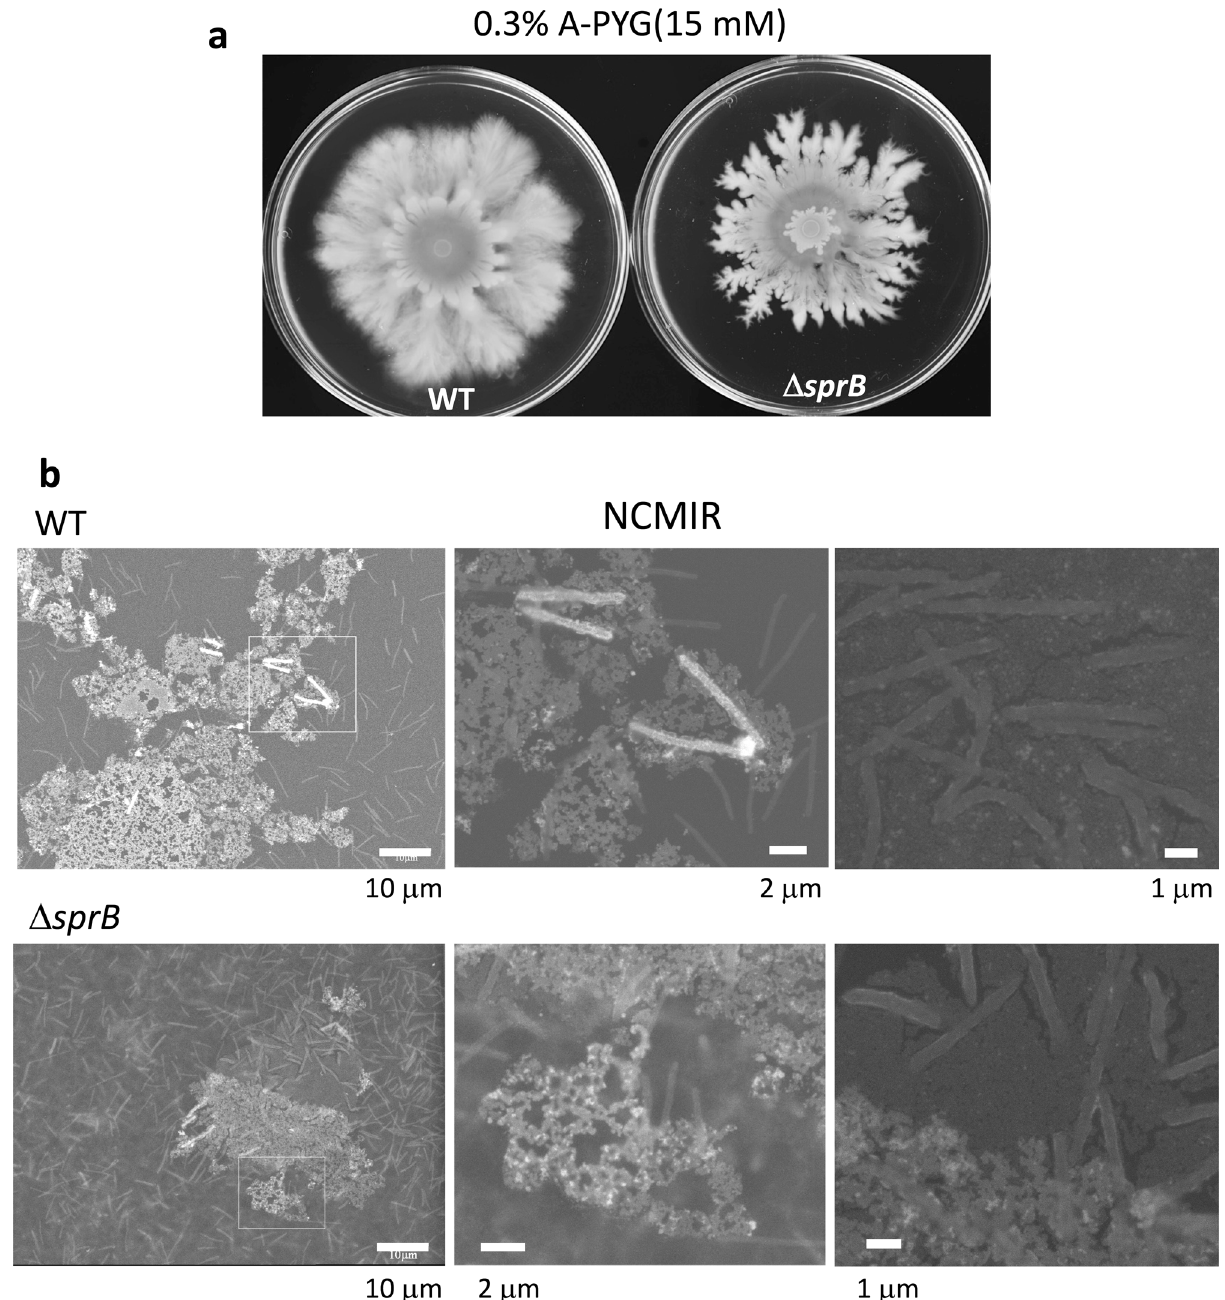
Figure 2. Colony spreading of WT and Δ sprB mutant F. johnsoniae on 0.3% A-PYG (15 mM). ( a ) Optical microscopy image. The branching pattern of the Δ sprB colony was less complex than that of the WT. ( b ) Spreading colonies of F. johnsoniae immersed in aqueous glucose buffer imaged by ASEM. The colonies were aldehyde-fixed and stained using the NCMIR method. The top of the biofilm was observed. Both WT and Δ sprB mutant cells were buried in the extracellular matrix covering the top of the colony, reflecting biofilm formation. Upper panels, WT; lower panels, Δ sprB